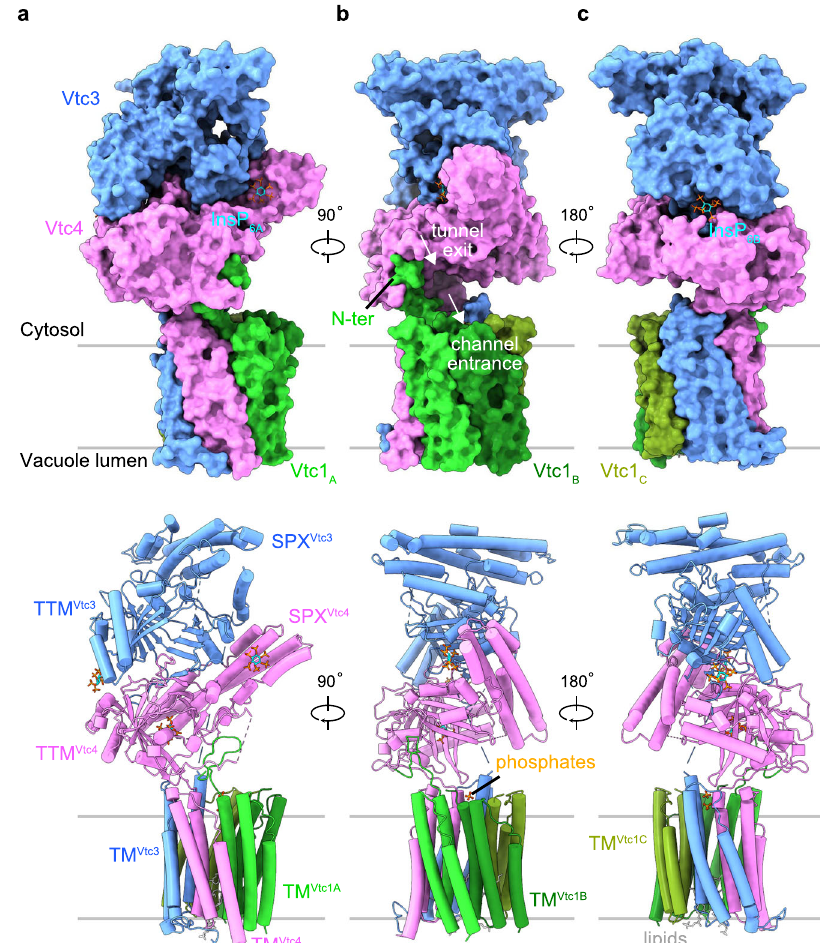
Fig. 2 | Structure of the InsP 6 -activated VTC complex. a – c Overall structure of Vtc1/Vtc3/Vtc4 R264A/R266A/E426N in complex with InsP 6 . Surface ( Top ) and cartoon ( Bottom ) representations are displayed in the same perspective. Vtc3 and Vtc4 are coloredinblueandpink,respectively.TheprotomerA,B,andCofVtc1arecolored